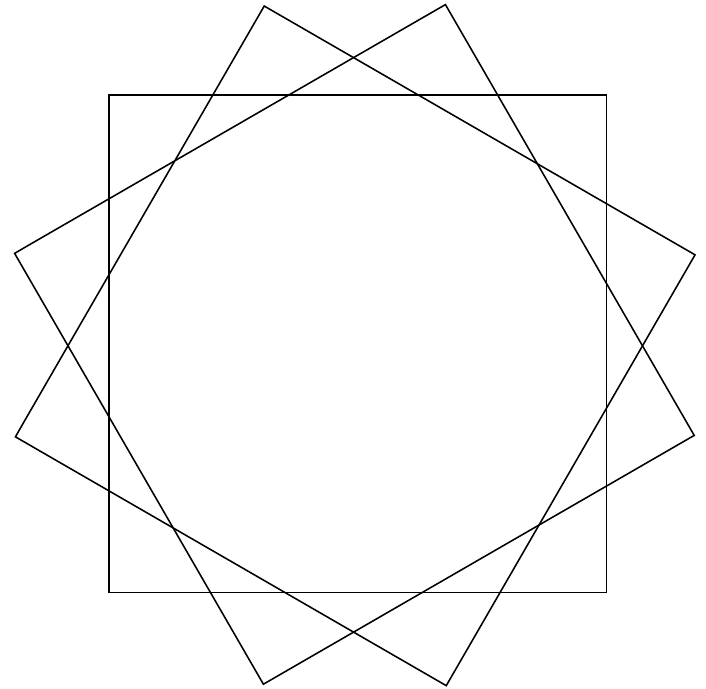
Figure 2. The case of three “boxes” and, accordingly, three approximating exponents. The picture becomes more and more rotationally symmetric as the number of boxes